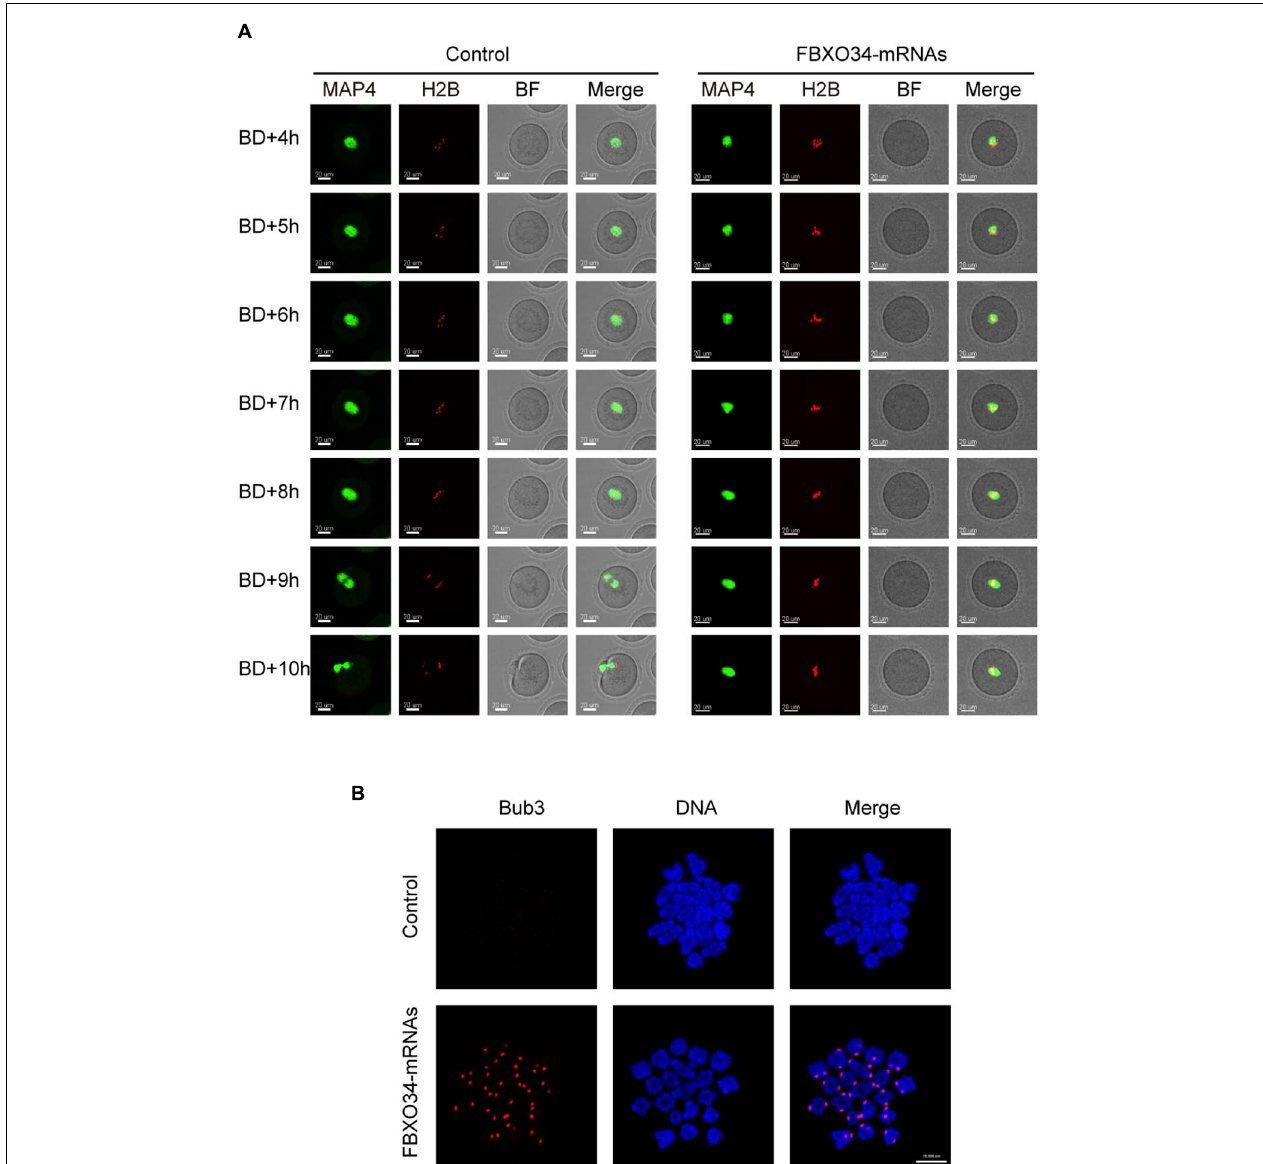
FIGURE 5 | Overexpression of FBXO34 caused continuous activation of SAC and MI arrest. (A) Control and FBXO34-overexpressed oocytes injected with MAP4-eGFP and H2B-mCherry mRNAs were incubated for 4 h and released to M2 medium for live-cell imaging. The spindle was labeled with MAP4-eGFP, and the chromosomes were labeled with H2B-mCherry. Images of live cells were taken every 30 min from the start of releasing to the end of 14 h later. Scale bar, 20 µ m. (B) After being incubated for 9.5 h, control and FBXO34-overexpressed oocytes were collected for chromosome spreading. Bub3 (red), DNA (blue). Scale bar, 10 µ